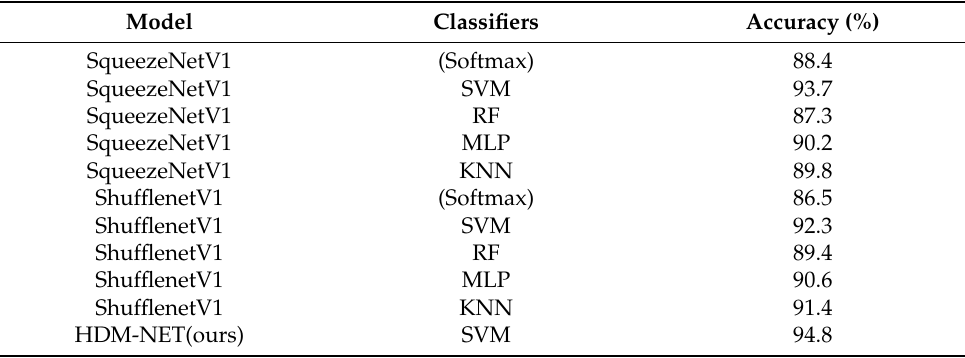
Table 5. The training time and detection time for HDM-net and other networks (VGG16